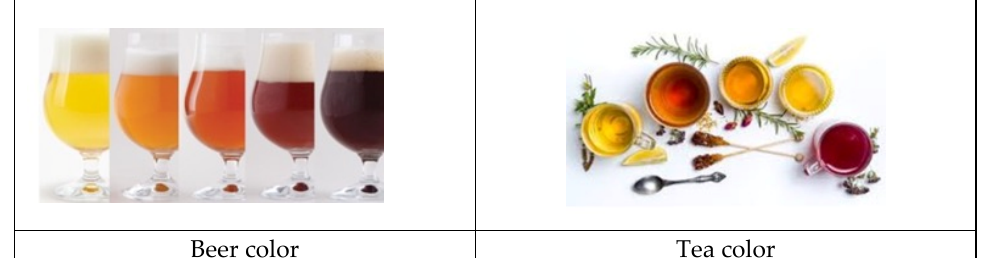
Figure 3. A variety of different beer colors and tea colors.